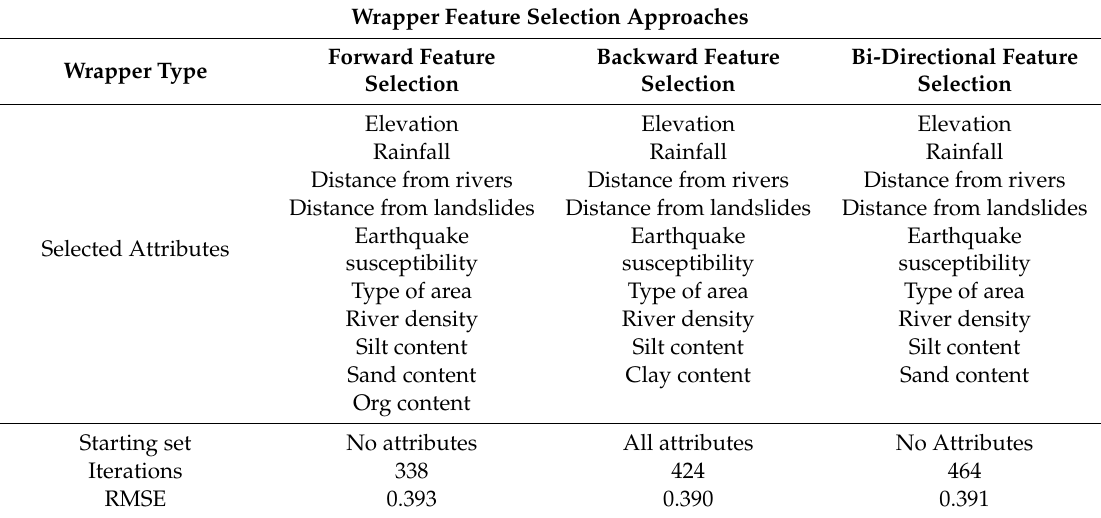
Table 4. Wrapper feature selection process: (1) Forward, (2) Backward, and (3) Bi-directional. Wrapper Feature Selection